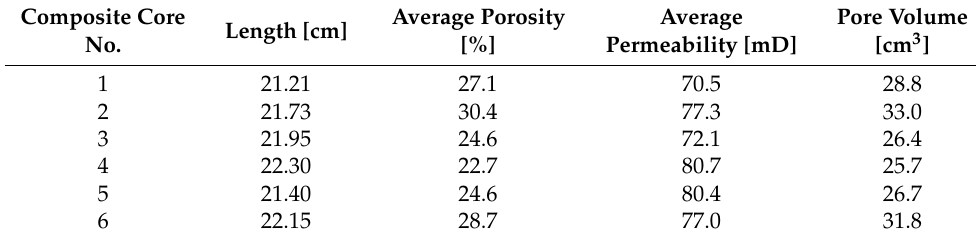
Table 6. Properties of composite